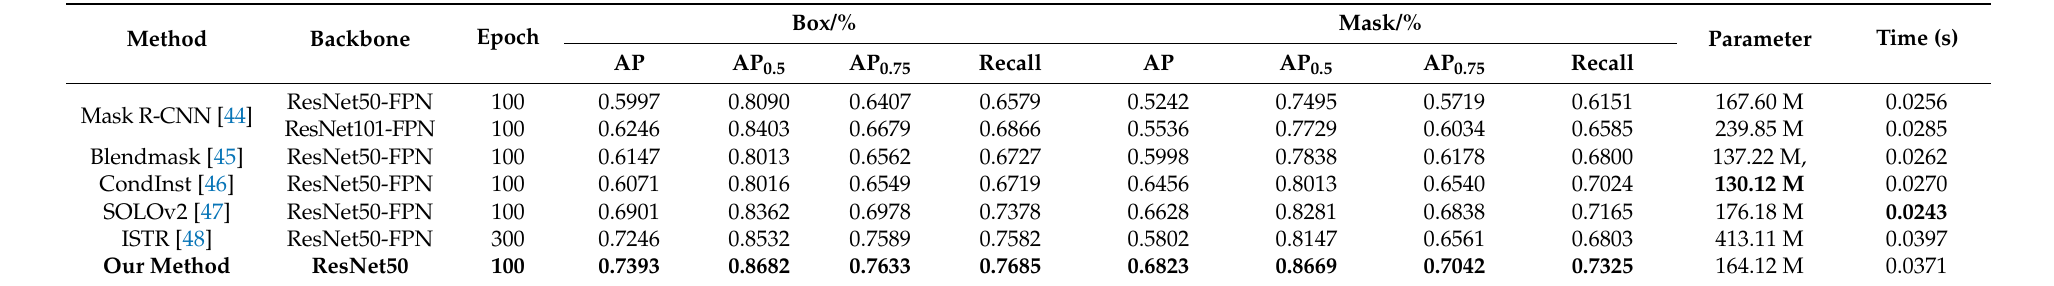
Table 2. Average precision bounding boxes (AP box ), average precision segmentation (AP mask ), runtime per image, and model parameter of instance segmentation in tomato disease spot and